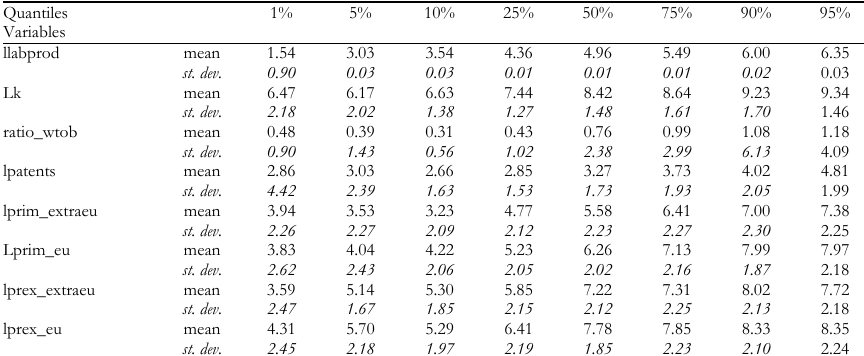
Descriptive Statistics for Manufacturing by labor productivity quantiles